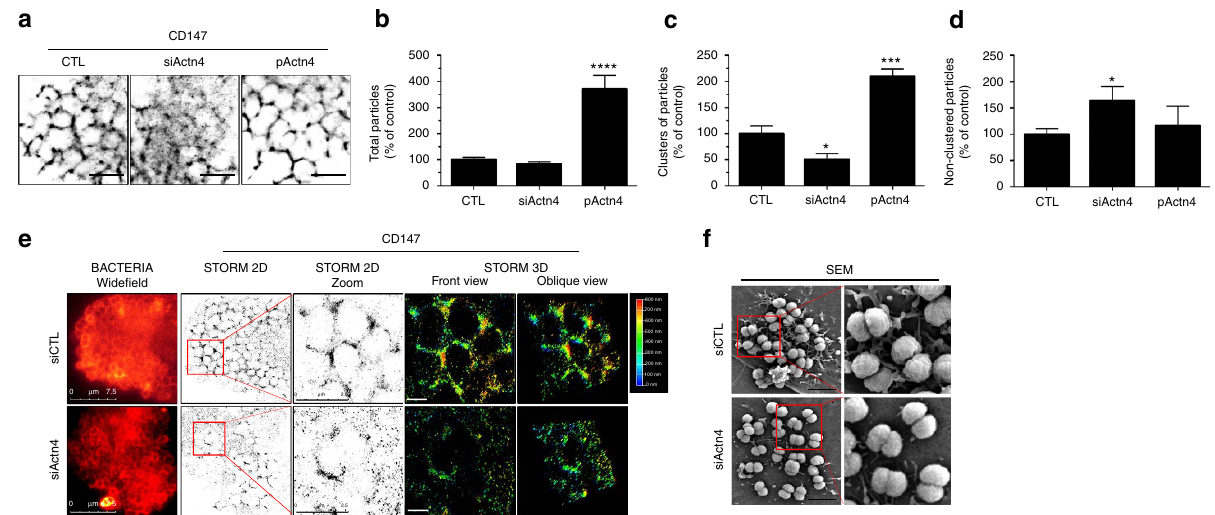
Figure 7 | a -Actn4 governs CD147 spatial organization and formation of membrane protrusions at bacterial adhesion sites. ( a – d ) Actn4 expression governs the organization of CD147 in clusters at sites of bacterial adhesion. ( a ) STORM reconstruction of CD147 distribution at bacterial adhesion sites in control (CTL), Actn4-depleted (siActn4) or Acnt4-overexpressing (pActn4) HBMEC cells, acquired on an iMIC imaging work station. Ten thousand frames were recorded and reconstructed using QuickPALM 1.1 ImageJ plug (scale bar, 5 m m). ( b ) Ratio of blinking CD147 receptors accumulated per 100 m m 2 area at bacterial adhesion sites in relation to the control condition (mean ± s.e.m., n ¼ 8, **** P o 0.0001, two-tailed Student’s t -test). ( c ) Ratio of CD147 clusters in 100 m m 2 at bacterial adhesion sites in relation to the control condition (mean ± s.e.m., n ¼ 8, * P o 0.05, *** P o 0.001, two-tailed Student’s t -test). ( d ) Ratio of non-clustered blinking CD147 receptors per 100 m m 2 at bacterial adhesion sites in relation to the control condition (mean ± s.e.m., n ¼ 8, * P o 0.05, two-tailed Student’s t -test). Quantification as described in the Method section. ( e ) Actn4 depletion alters CD147 spatial distribution at bacterial adhesion sites. HBMECs transfected with siRNA targeting Actn4 (siActn4) or control siRNA (siCTL) were infected for 1h with meningococci and stained for CD147 and Bacteria. Shown are the bacteria acquired in widefield, the 2D- and 3D-STORM reconstructions of CD147 clusters at bacterial adhesion sites, imaged on a Leica SR GSD and the depth colour code (0–800nm). Fifty thousand frames were recorded for each acquisition and reconstructed using the Leica Application Suite (LAS X) core module (scale bar, 1 m m). ( f ) Acnt4 depletion alters the formation of membrane protrusions at bacterial adhesion sites. HBMECs transfected with siRNA targeting Actn4 (siActn4) or control siRNA (siCTL) were infected for 1h with meningococci and analysed by scanning electron microscopy (SEM). Shown are representative scanning electron micrographs of infected control and Actn4-depleted HBMECs (original magnification (cid:2) 10,000) (scale bar, 5 m